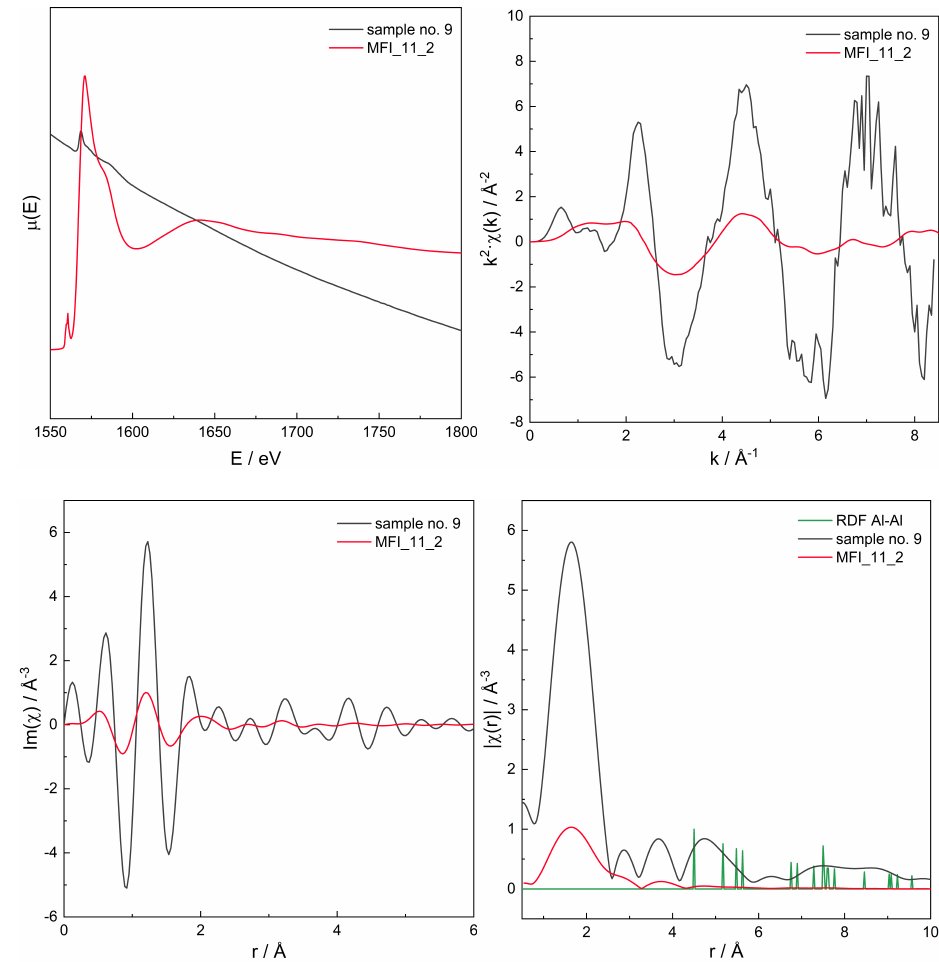
Figure 10. Spectrum of µ ( E ) ( upper left panel ), k 2 χ ( k ) ( upper right ), (cid:61) χ ( r ) ( lower left ), and | χ ( r ) | ( lower right ) for sample no. 9 (MFI of Si/Al = 11) and simulation for computational model labelled MFI_11_2. Matching RMS = 0.0658. The simulation model characterised by Al–Al distances of: 4.6, 5.5, 7.2, 9.3, and 10.4 Å.